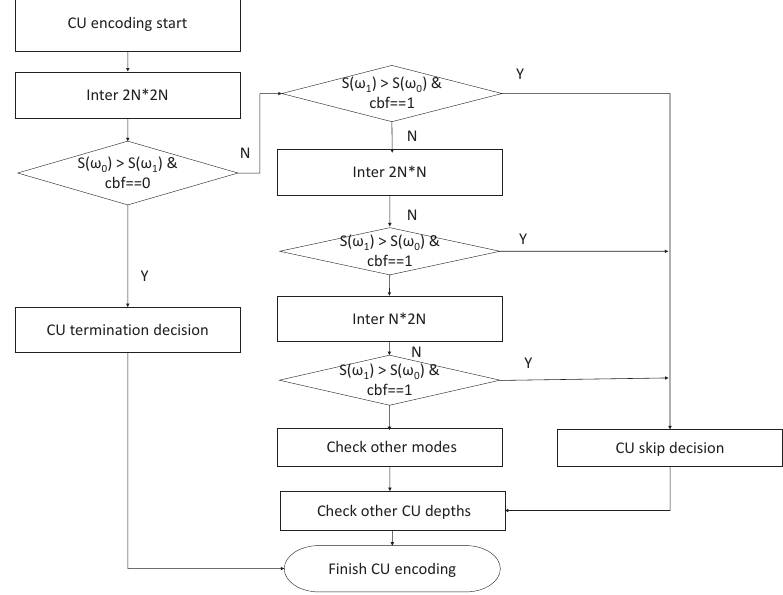
Figure 7. Flowchart of the proposed prediction unit (PU) mode